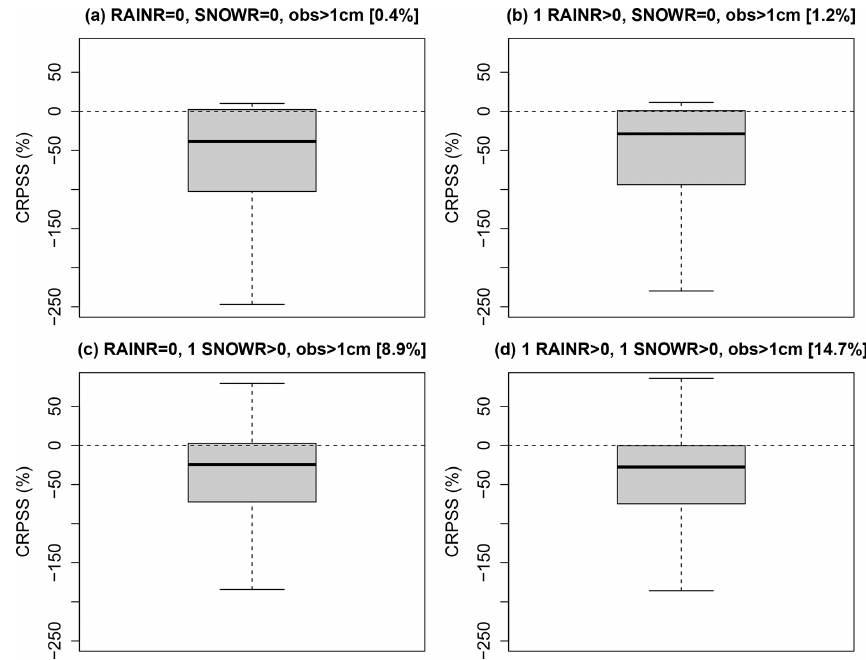
Figure 8. Relative CRPS values of EMOS versus QRFs as percentages, with QRFs as a reference, for all dates and stations and for a 1d lead time. Only dates with a positive observation greater than 1cm are selected and for different classes of predictors. (a) All forecast members of rain rate and snow rate equals to zero. (b) At least one member with a positive rain rate value and all forecast members of snow rate equals to zero. (c) All forecast members of rain rate equal to zero and at least one member with a positive snow rate value. (d) At least one member with a positive rain rate value and one member with a positive snow rate values. Values in brackets indicate the corresponding frequencies, in percent, among all the